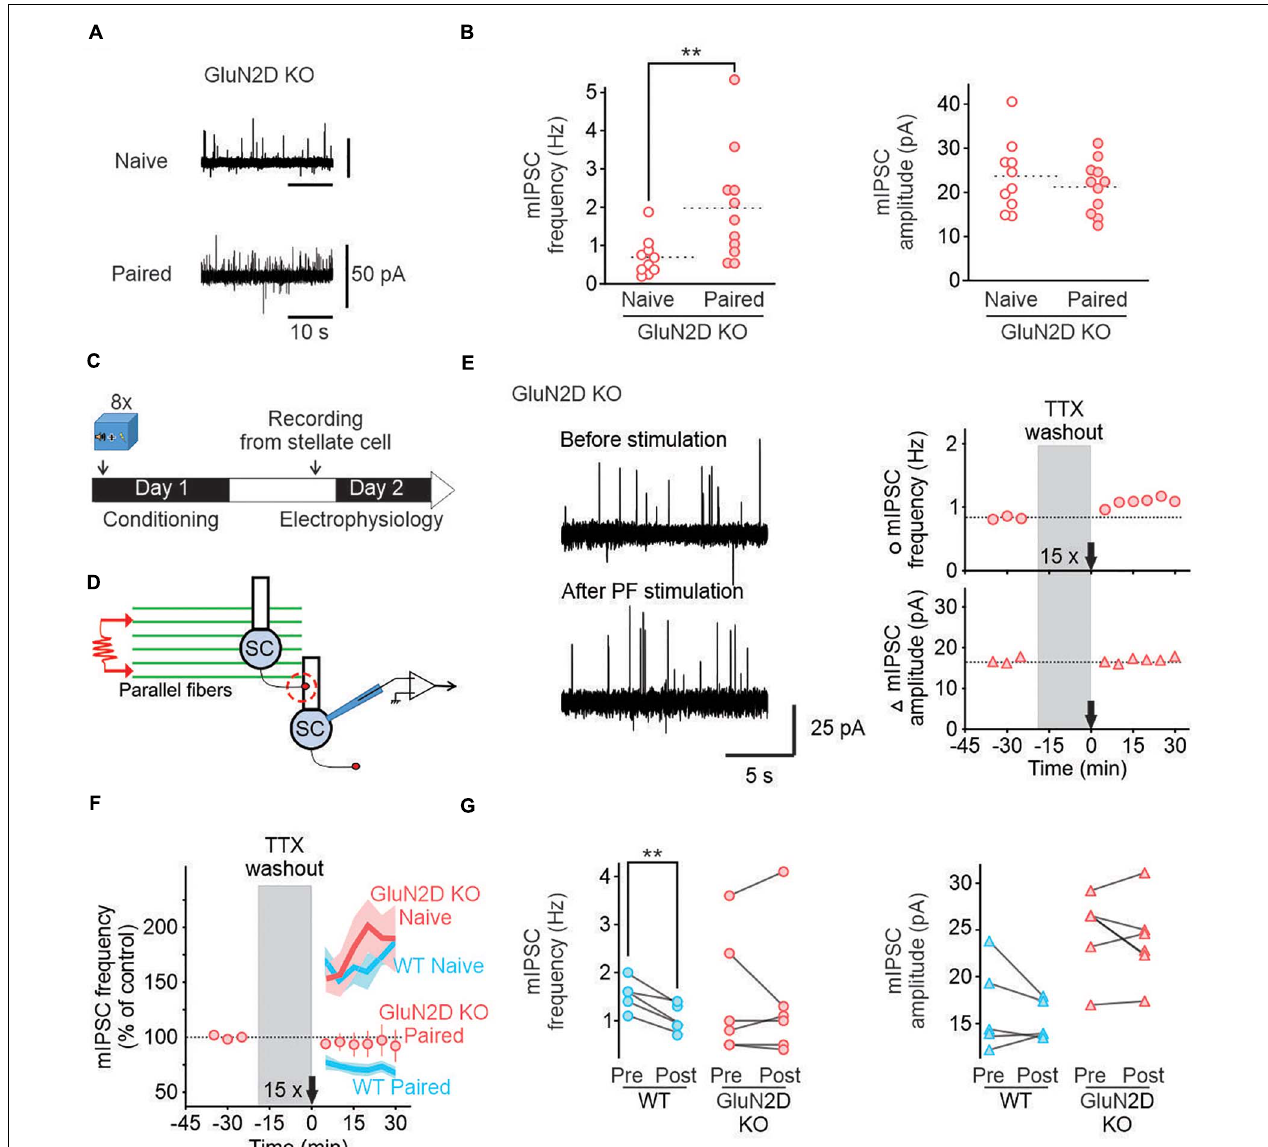
FIGURE 3 | Deletion of GluN2D subunits abolishes I-LTD stim in conditioned mice. (A) Representative traces of mIPSCs in stellate cells from naïve ( top ) and paired ( bottom ) GluN2D KO mice. (B) Individual frequencies and amplitudes of mIPSCs in naïve (open red circle, n = 10) and paired mutant animals (filled red circles, n = 11). (C) Fear conditioning protocol for electrophysiology experiments. (D) Schematic of the experimental procedure. (E) Left , Example traces of mIPSCs recorded in MLIs before ( top ) and after ( bottom ) parallel fiber stimulation (15 trains of four pulses at 100 Hz) in GluN2D KO mice after fear conditioning. Right , corresponding time course of mIPSC frequency (top) and amplitude (bottom). (F) Average time course of mIPSC frequency normalized to before parallel fiber stimulation in GluN2D KO mice (red circles, values are mean ± SEM) after fear learning. Wildtype naïve and paired group average values (blue lines) and SEM (light blue area) are data from Figure 3 represented for reference. (G) Summary of the individual frequencies ( left ) and amplitudes ( right ) before ( Pre ) and 15–30 min after parallel fiber stimulation ( Post ). ** P < 0.01. Statistical analysis values can be found in the Supplementary Table 1